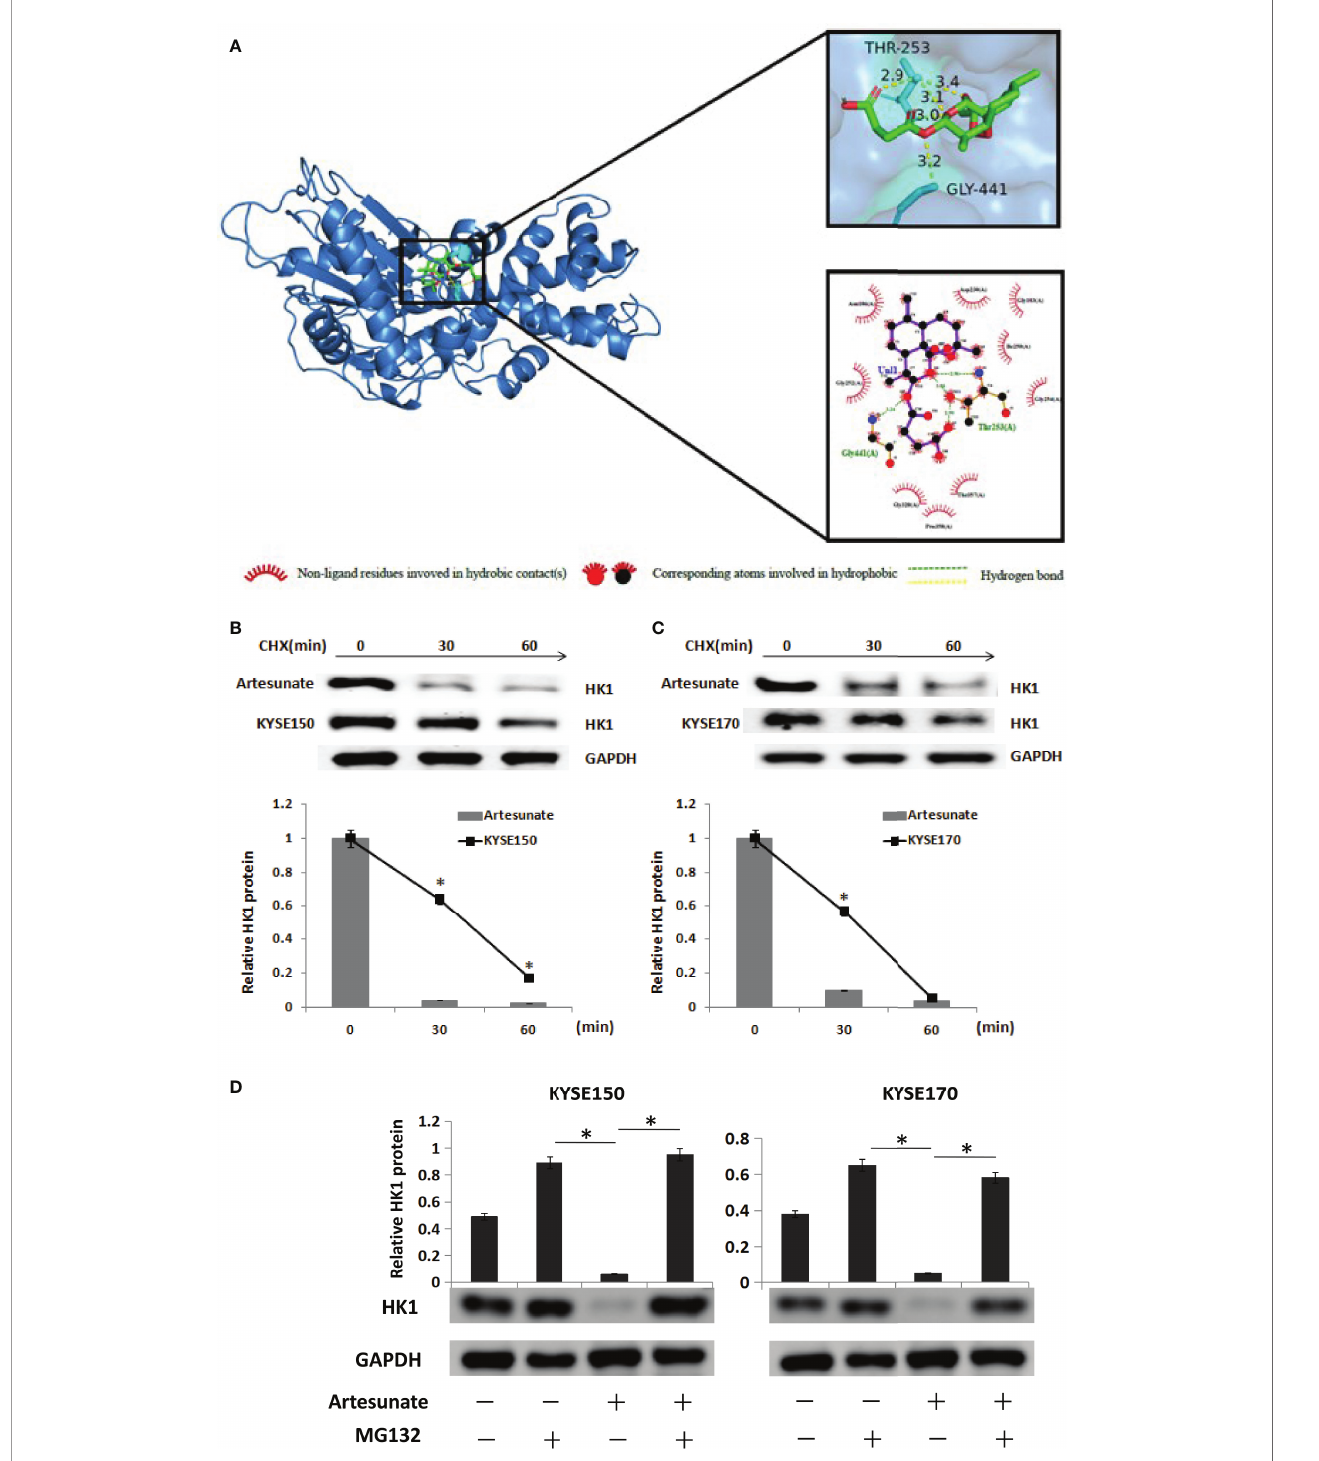
FIGURE 4 | Artesunate targets and degrades HK1. (A) The binding site of artesunate and HK1. (B) The half-life of HK1protein was assessed in KYSE150 cells. Cells were treated with artesunate. (C) The half-life of HK1 protein was assessed in KYSE170 cells. Cells were treated with artesunate. (D) EC cells with artesunate treatment and control cells were treated with or without MG132 (5 m M) for 12h. *P <